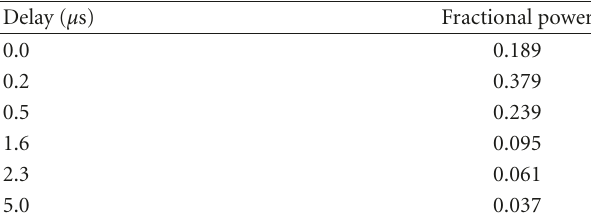
Table 2: Power delay profile in the typical urban area.